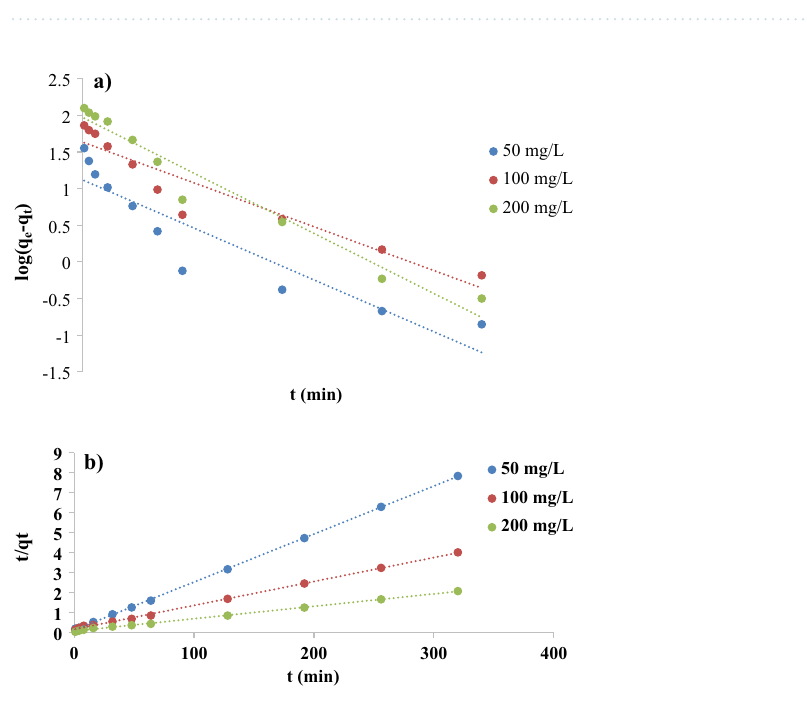
Figure 9. Impact of adsorption time on KMnO 4 adsorption by Ox-FVESP.